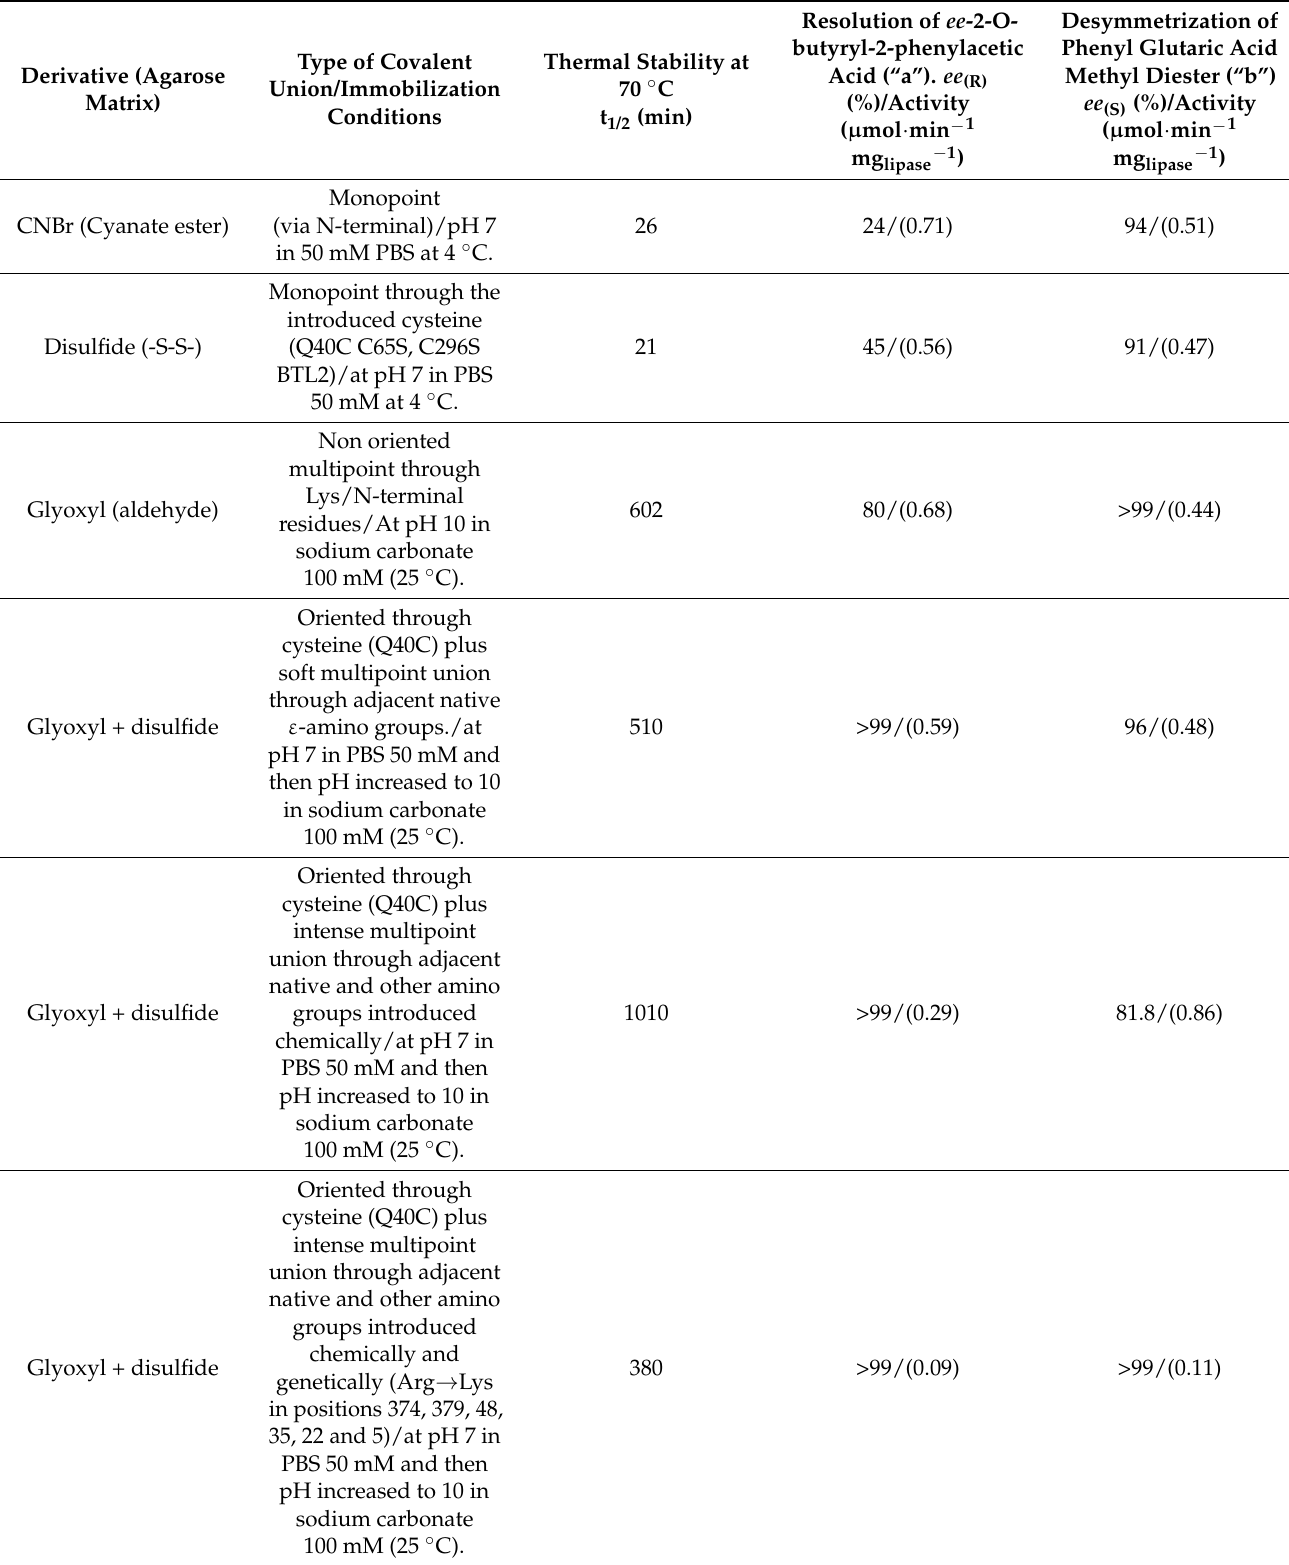
Table 3. Intensity of enzyme-support union in BTL2 covalent derivatives